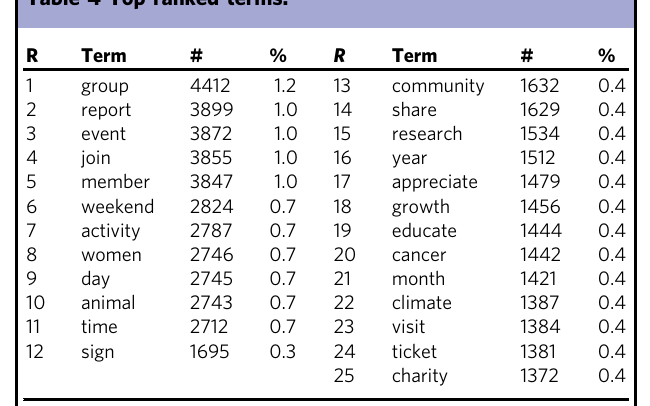
Table 4 Top ranked